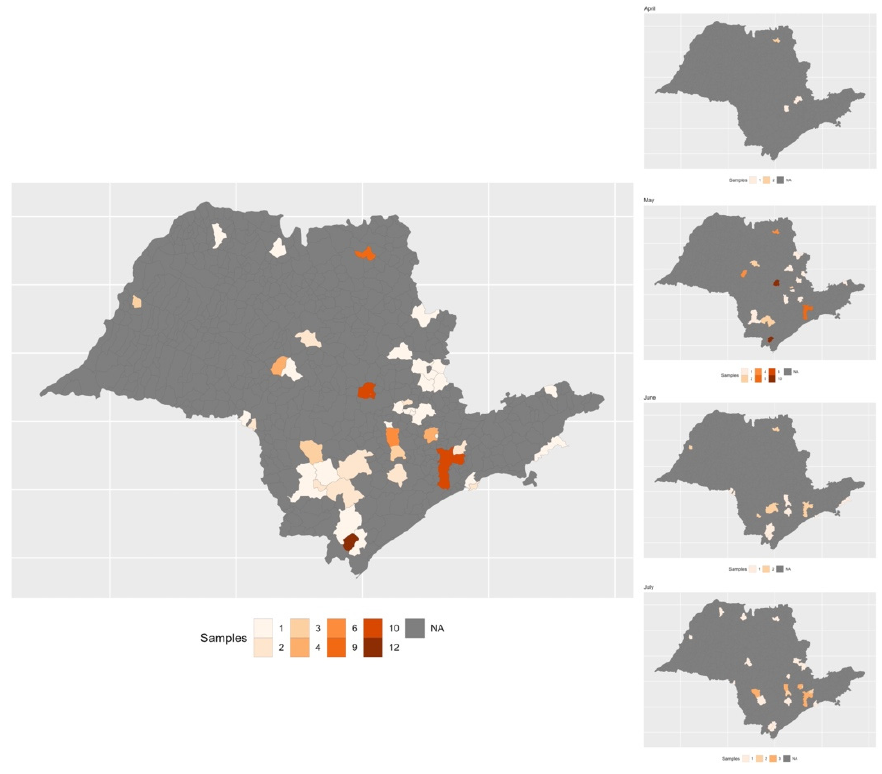
Figure 1. Geolocation of the 111 samples with mutations in the same region of N gene and monthly based frequency from April to July 2021.